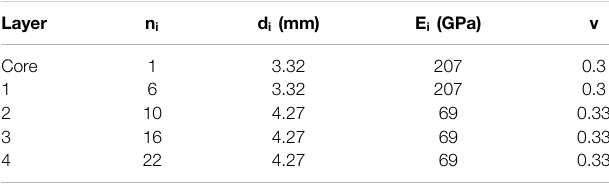
TABLE 1 | Characteristics of the Bersfort conductor (Lalonde et al.,